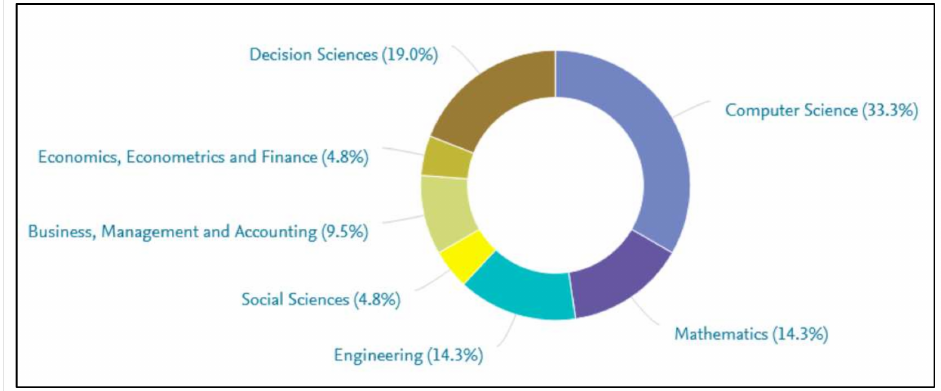
Figure 4. SciVal classification of the author’s publication by subject